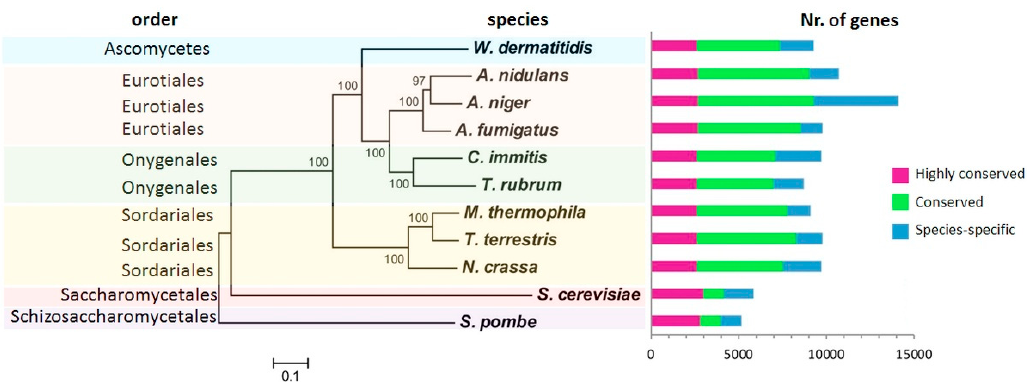
Figure 1. Comparison of the gene conservation and their phylogenetic proximity among selected fungal species. The phylogenetic tree was reconstructed using the MUSCLE alignment based on more than 2000 single copy genes. The number of highly conserved genes found in each species is depicted in magenta, the genes conserved in at least two species are marked in green and the unique genes are colored in sky blue (modified from [13]).